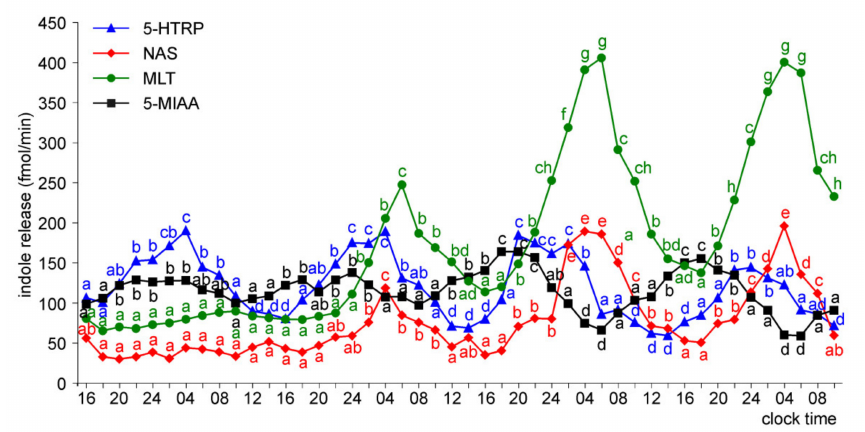
Figure 7. Release of 5-HTRP, NAS, MLT, and 5-MIAA (means, n = 3) from pineal organs of ED 22 embryos incubated under a 12L:12D cycle. The same letters indicate means, which are not significantly different between time-points.